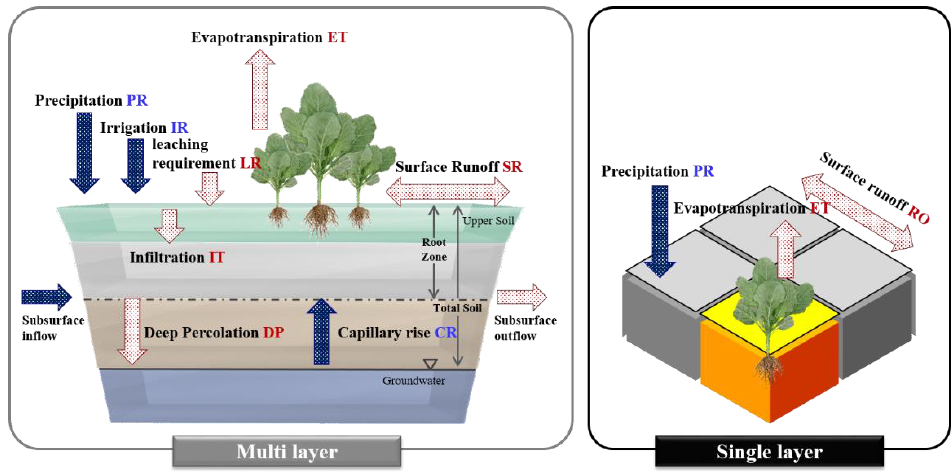
Figure 2. Schematic diagram of soil water balance model.